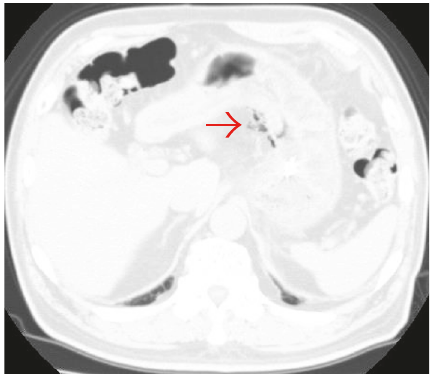
Figure 1: Case 1 underwent endoscopic submucosal dissection (ESD) for early gastric cancer in the upper third of the stomach. A vessel had been coagulated and cut (arrow). No perforation was observed just after completion of ESD.